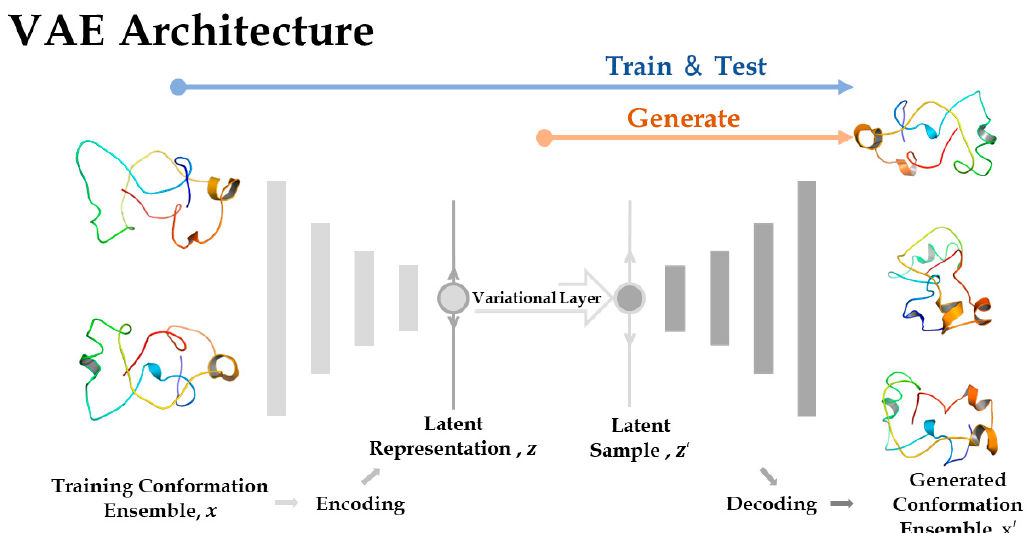
Figure 7. An overview of the architecture of variational autoencoders.